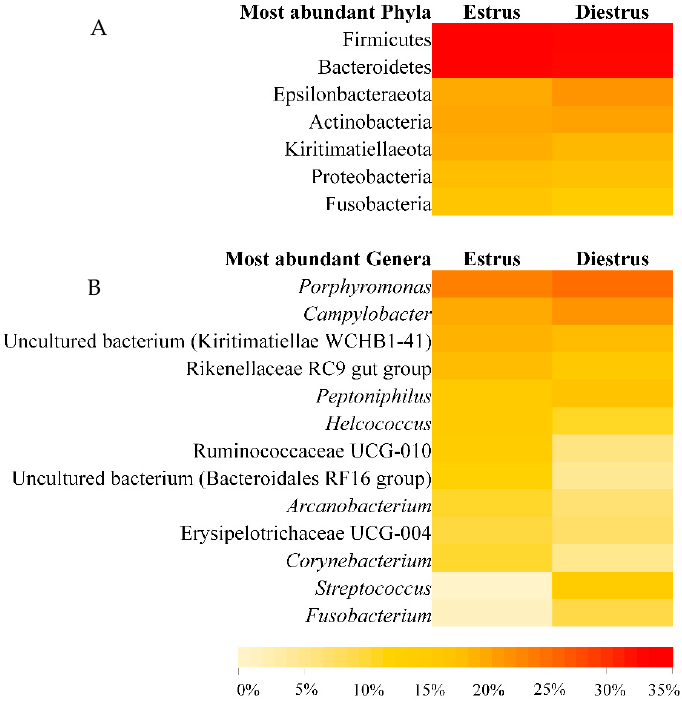
Figure 3. Heatmap of the mean relative abundance at the phylum level ( A ) and genus level ( B ) for equine vaginal samples at the different sampling points (estrus and diestrus). See color code scale based on the relative abundance on the bottom.